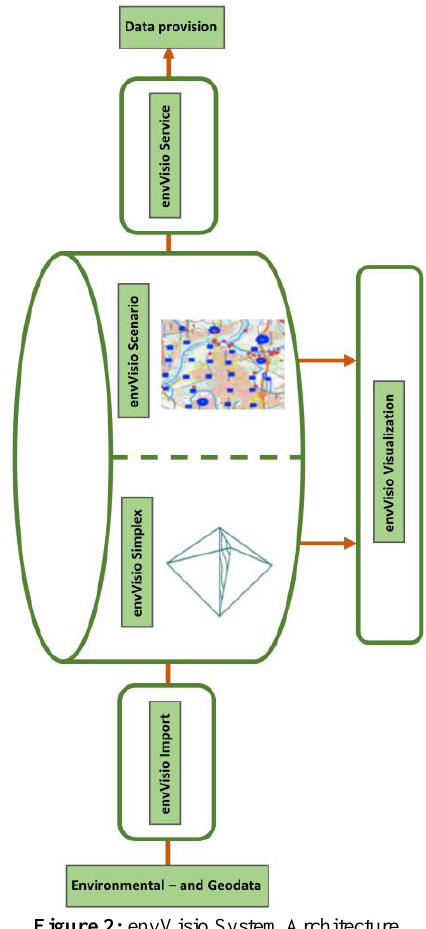
Figure 2: envVisio System